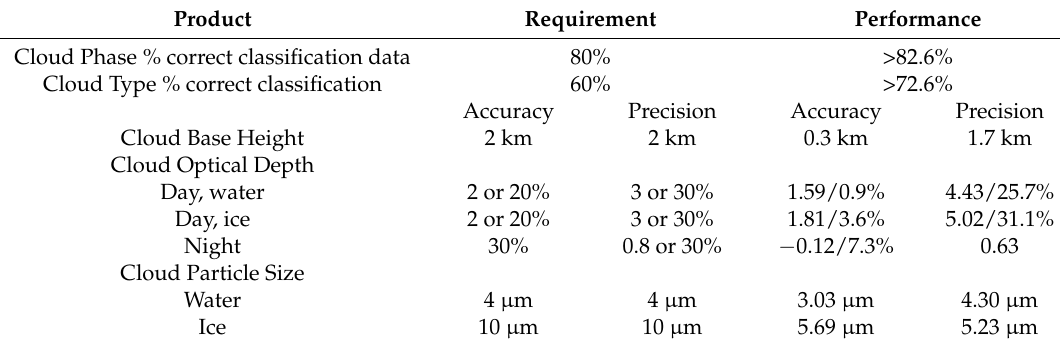
Table 3. S-NPP VIIRS cloud products performance (accuracy: magnitude of the mean measurement errors; precision: the standard deviation of the measurement errors [27]).